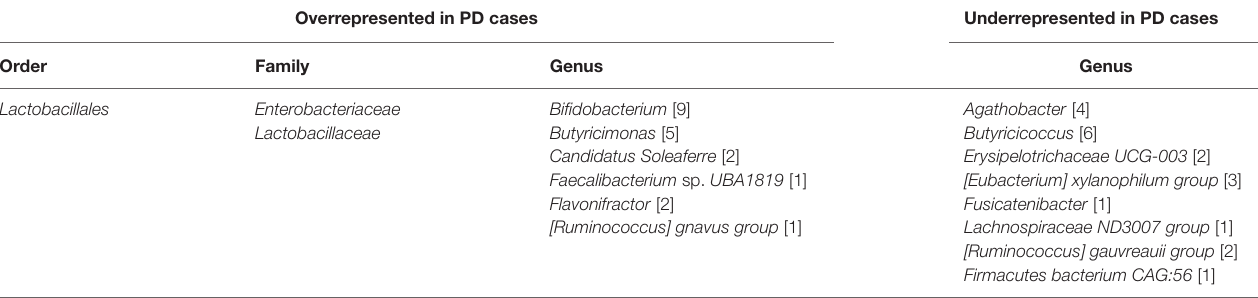
TABLE 3 | Gastrointestinal microbiota compositional differences between Parkinson’s Disease patients and Household Controls. Overrepresented in PD cases Underrepresented in PD cases Order Family Genus Genus